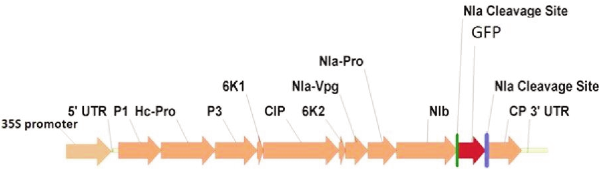
Fig. 1 - Schematic representation of the viral construct contai- ning GFP under the 35S promoter that was used in this expression analysis. The foreign gene insertion site is between NIb (nuclear inclusion protein b) and CP (the virus coat protein gene) provided by NcoI and NheI restriction endonuclease